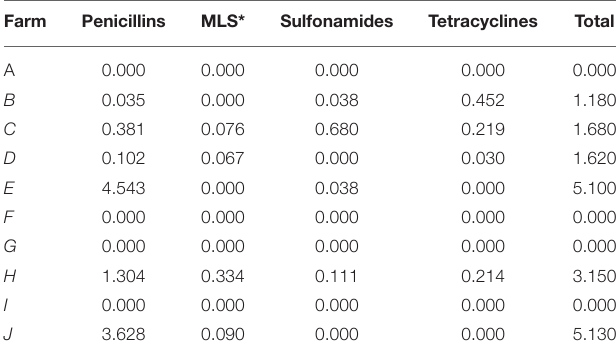
TABLE 1 | Annual antimicrobial consumption referred to 2019 of enrolled